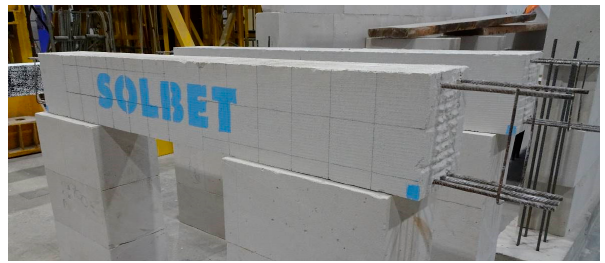
Figure 5. Tested elements with the reinforcement broken down at its ends.